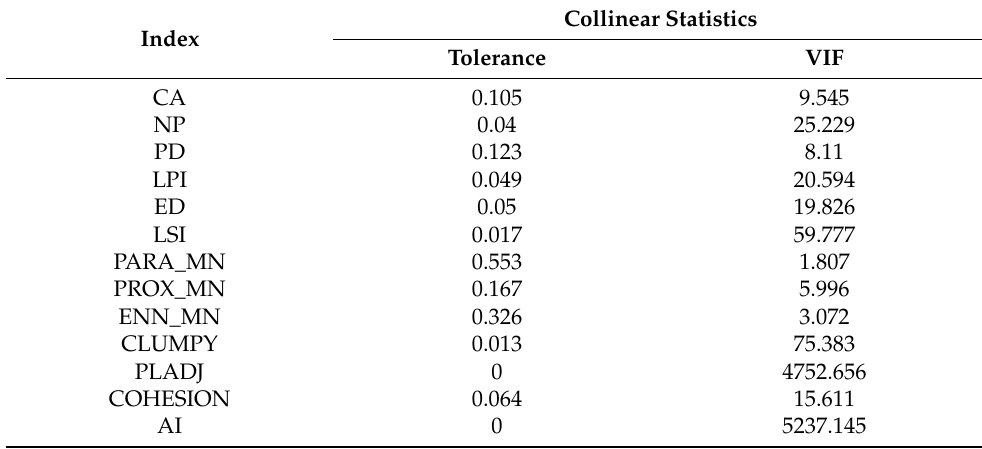
Table 3. Statistics of multicollinearity test results.